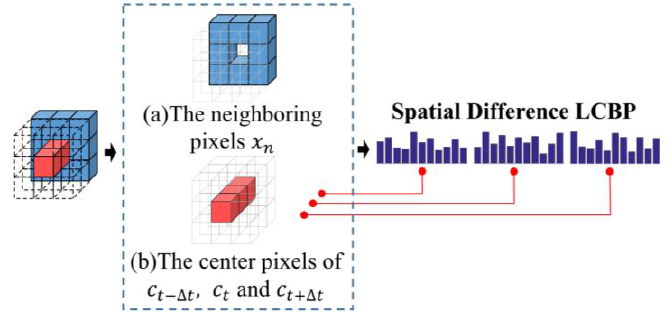
Figure 4. The encoding process of Spatial Difference LCBP. ( a ) The sampling range of the neighboring pixels in the cube space. ( b ) The sampling range of the center pixels in the cube space.